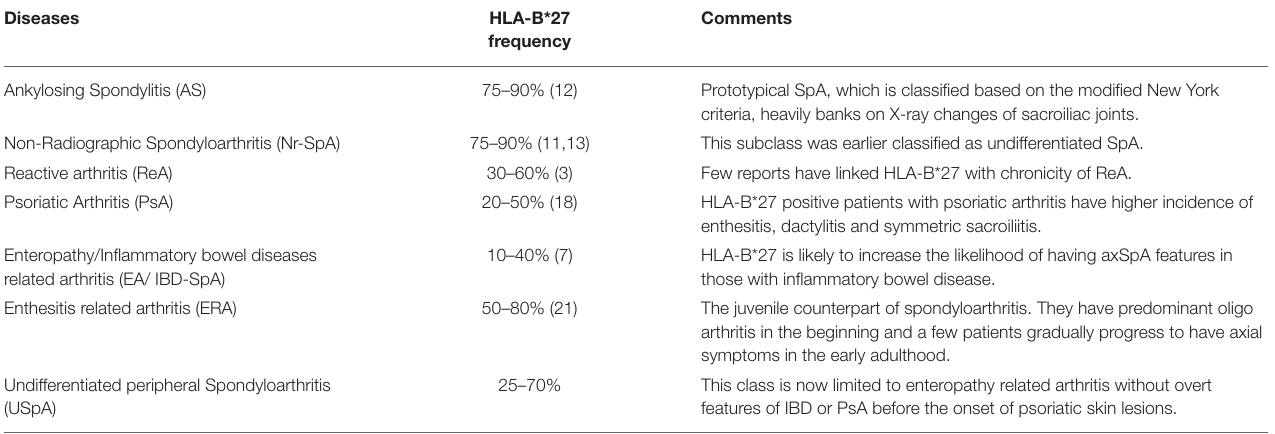
TABLE 1 | Association of HLA-B*27 and various classes of Spondyloarthritis.